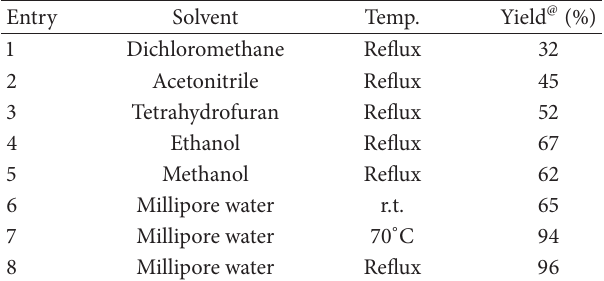
Table 2: Effect of ZnO nanoparticle solvent on the synthesis of pyranopyrazoles.